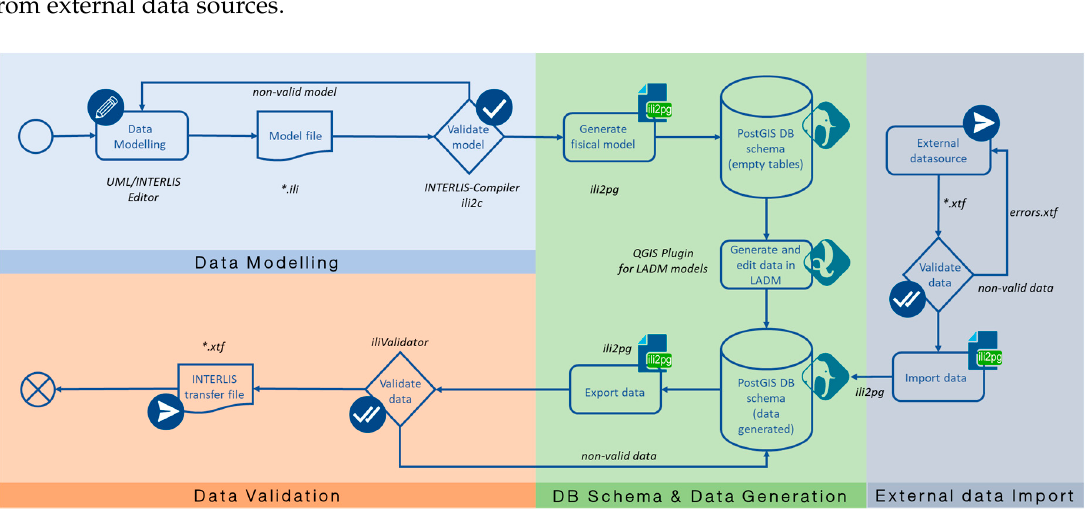
Figure 6. INTERLIS tools and workflow ([6], edited).